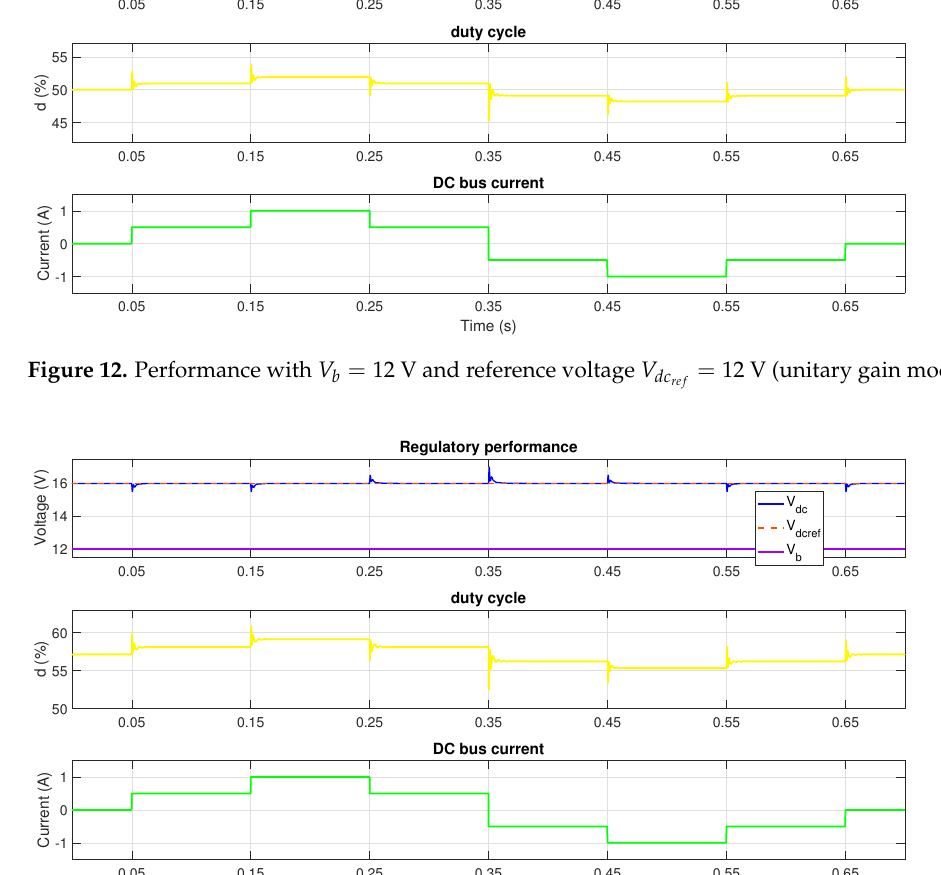
Figure 13. Performance with V b = 12 V and reference voltage V dc The same previous test was conducted while considering two batteries in a series connection, i.e., V b = 24 V, which enabled us to test the adaptability of the control